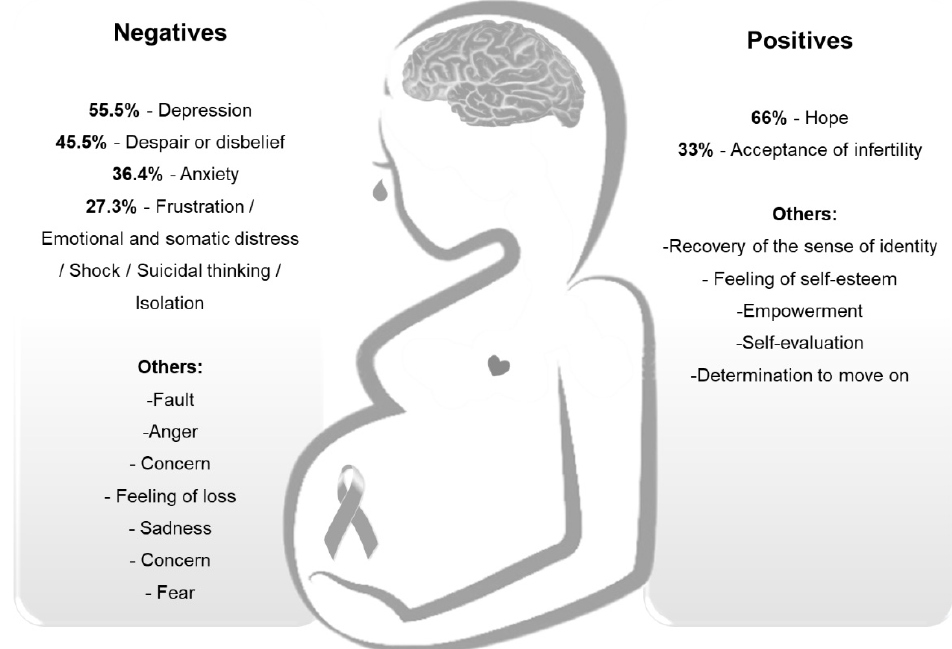
Figure 2. Negative and positive psychosocial aspects of grief in women experiencing infertility undergoing infertility treat-